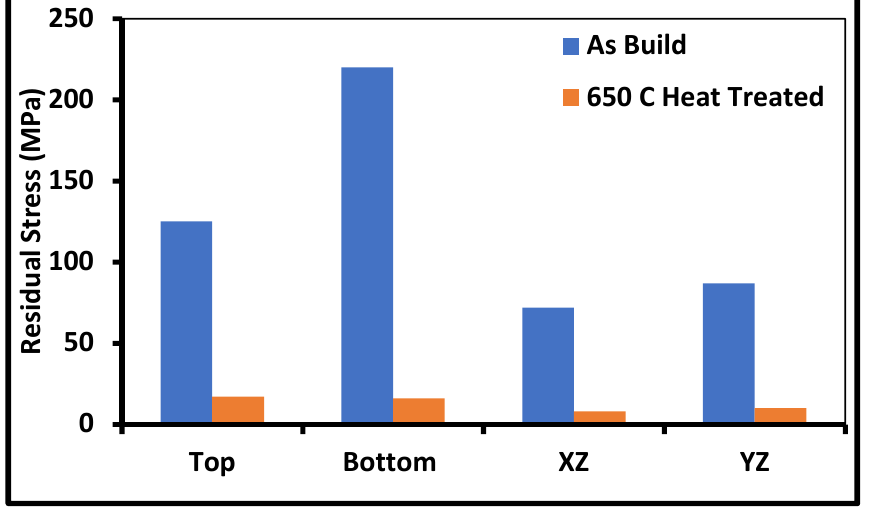
Figure 22. Residual stress: as-built vs. post-heat treatment of SS316L [35].